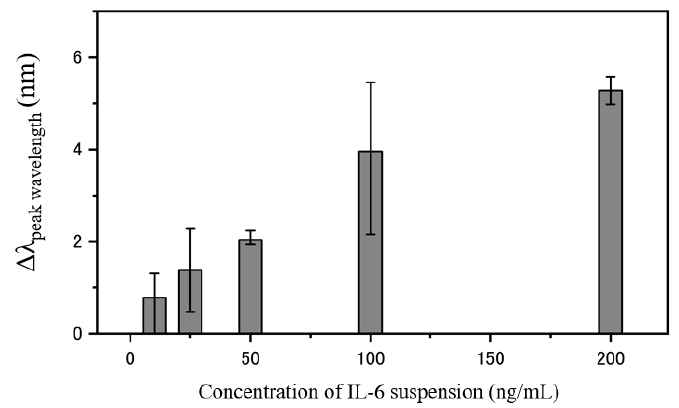
Figure 3. Calibration curve for concentrations 10 ng / mL, 25 ng / mL, 50 ng / mL, 100 ng / mL and 200 ng / mL IL-6 peak transmittance using fabricated plasmonic